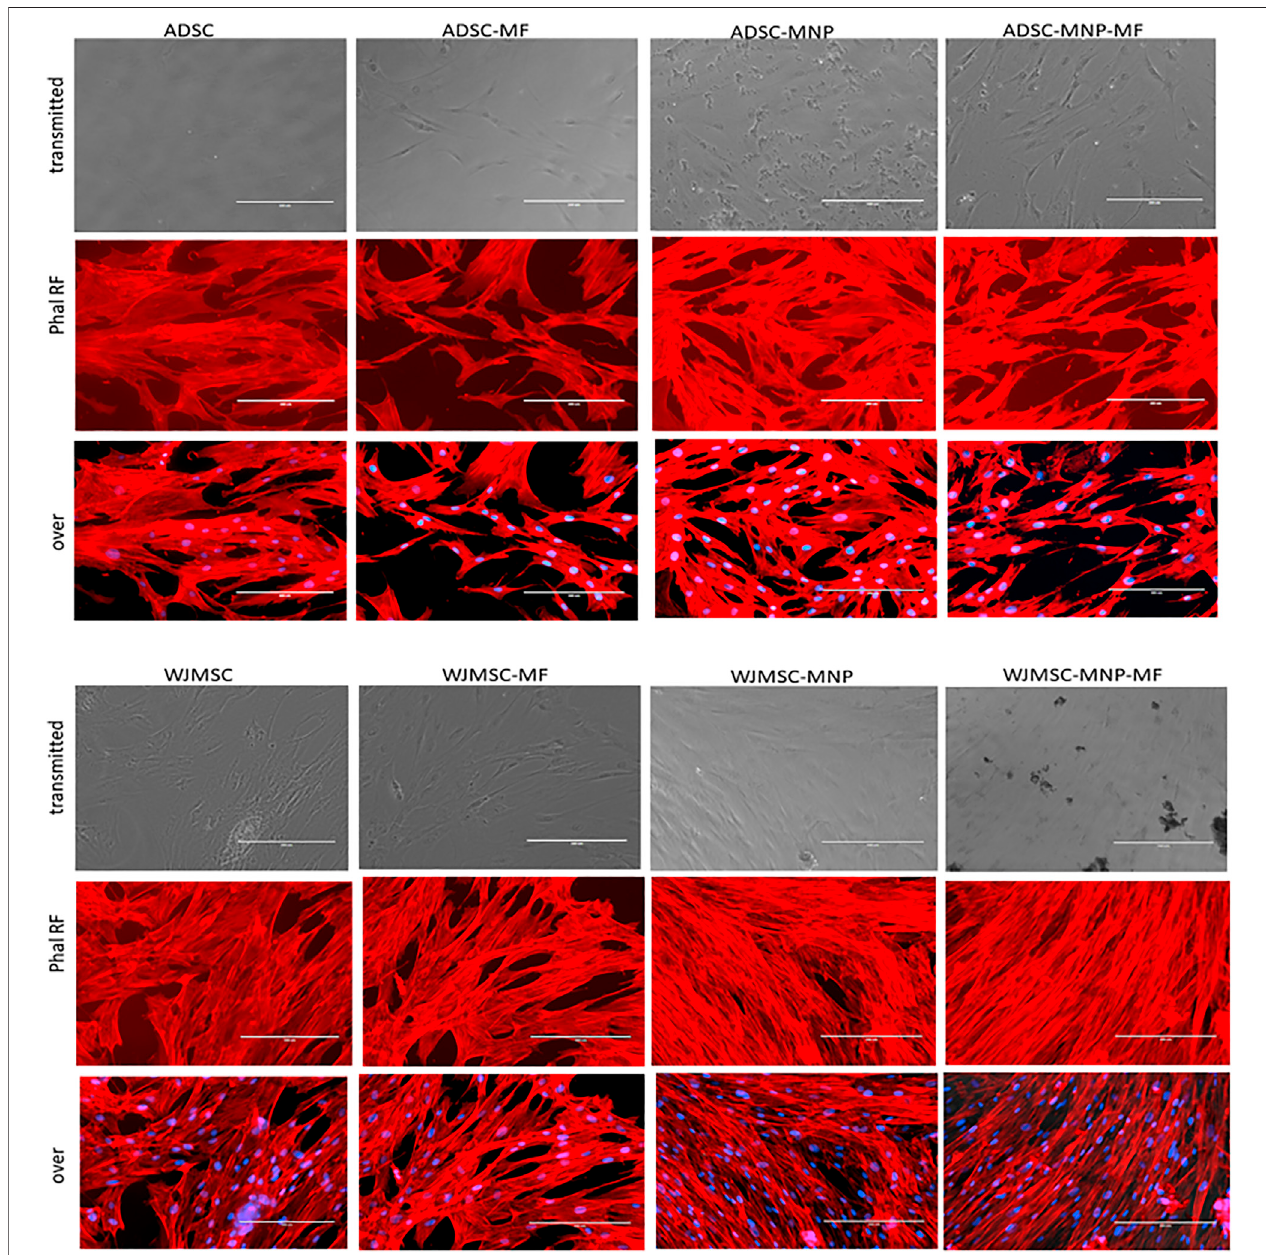
FIGURE4| Cytoskeletal fi bbersinloadedandnon-loadedADSCandWJMSCdemonstratingqualitativelyactin fi bbersshrinkageincellsexposedtoMF,especially for MNP loaded cells. Texas Red ™ -X Phalloidin staining, nuclei stained with DAPI; EVOS inverted fl uorescent microscope 20 × magni fi cation.